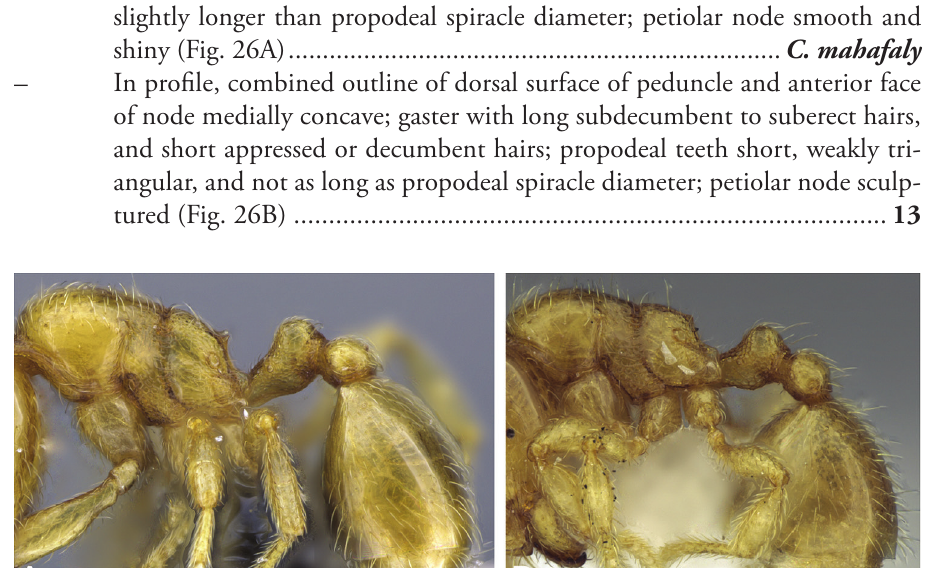
shiny (Fig. 26A) ........................................................................ C. mahafaly